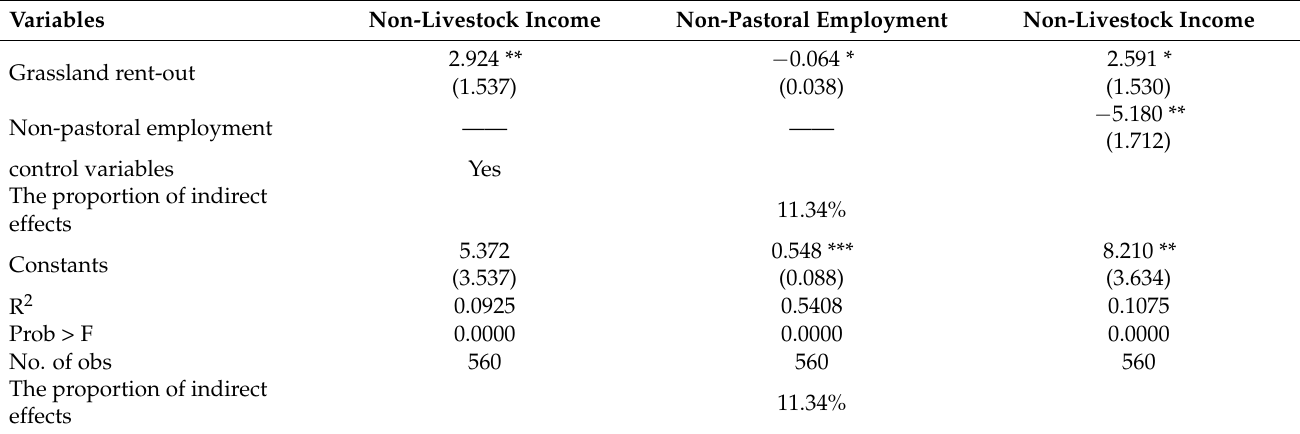
Table 9. Mediating effect test of grassland